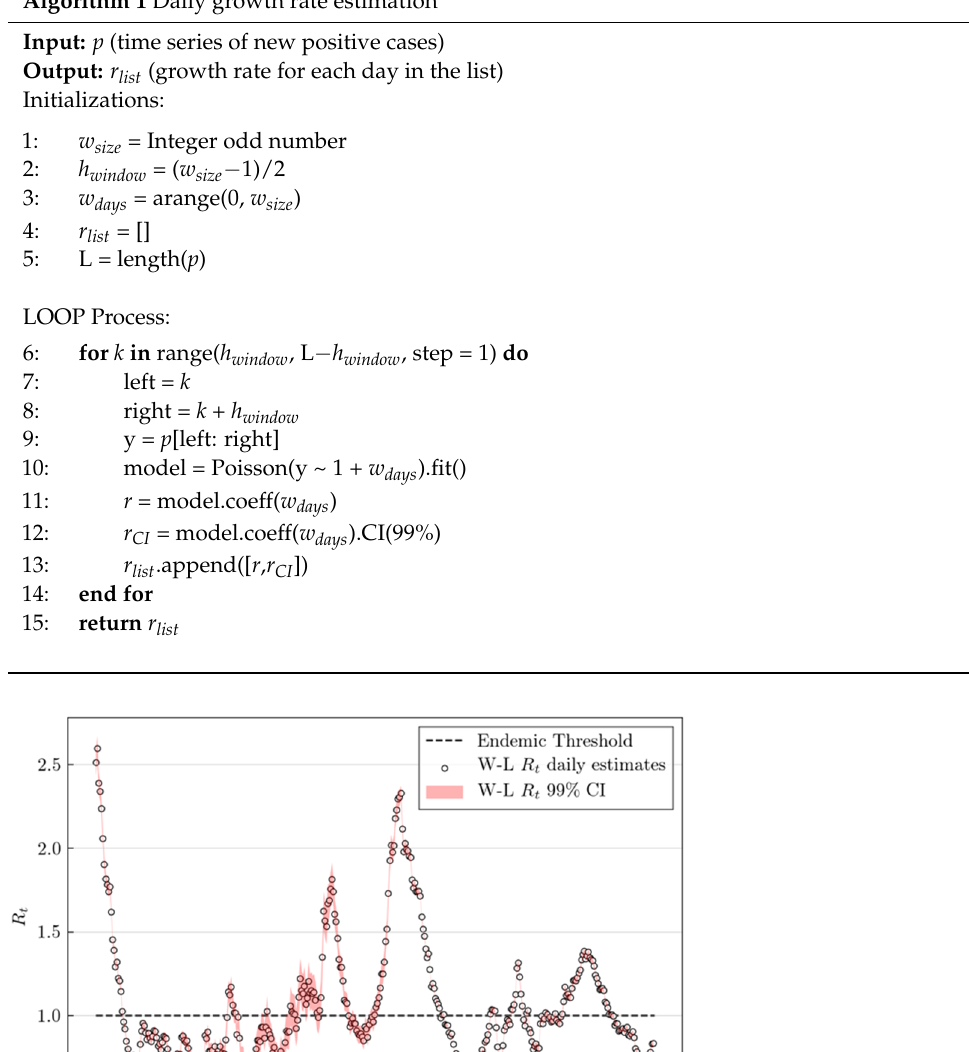
Algorithm 1 Daily growth rate estimation